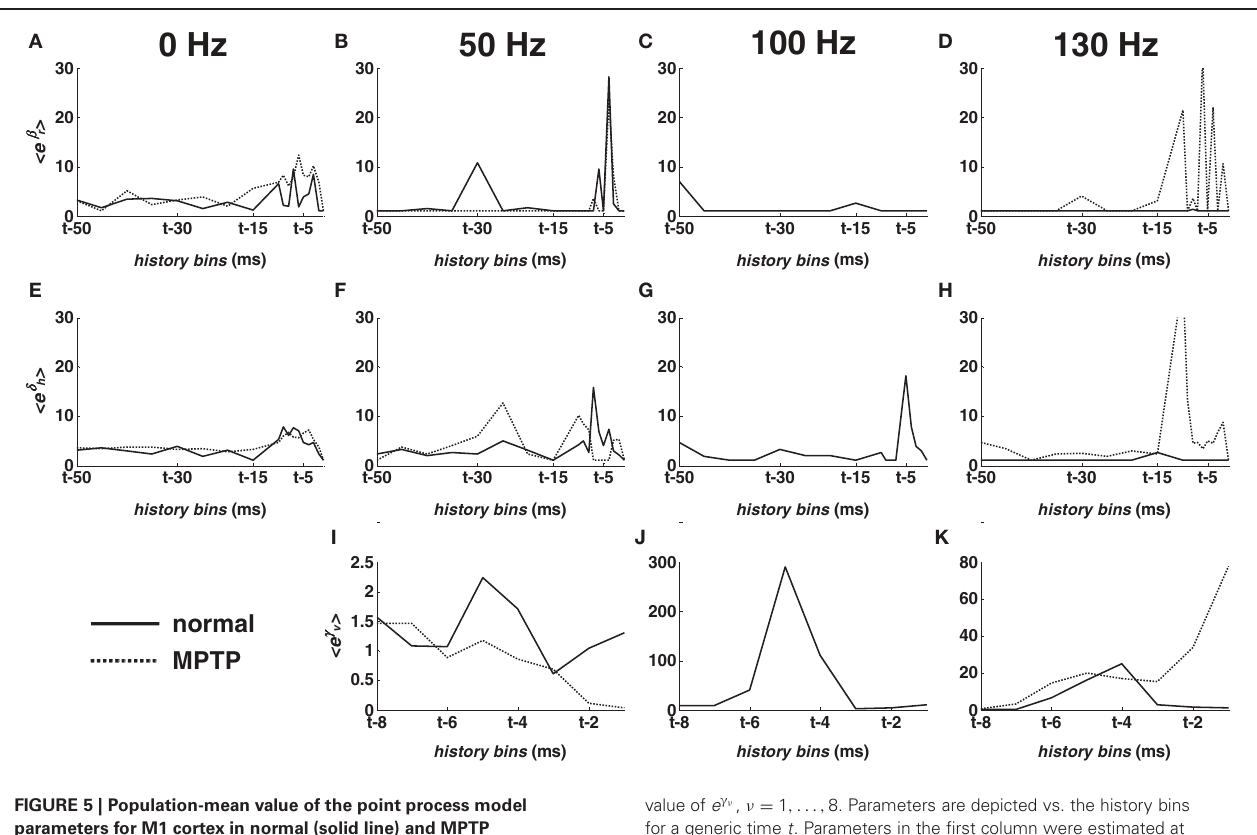
FIGURE 5 | Population-mean value of the point process model parameters for M1 cortex in normal (solid line) and MPTP (dashed line) conditions (animal A). (A–D) Mean value of e β r , r = 1 ,..., 18. (E–H) Mean value of e δ h , h = 1 ,..., 18. (I–K) Mean